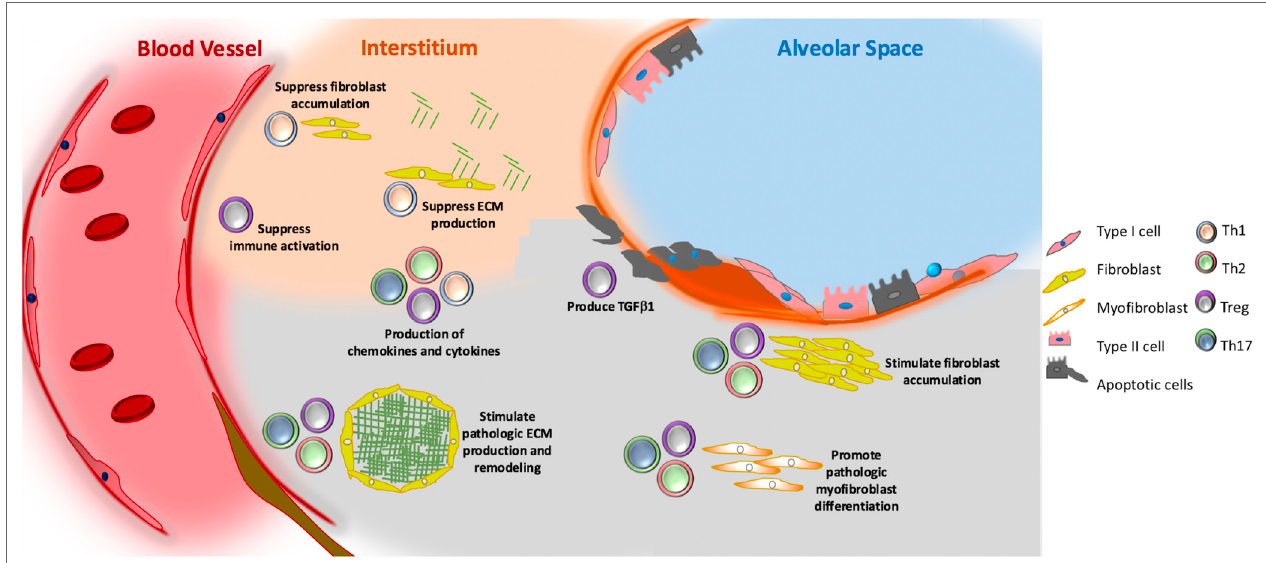
FigURe 3 | Putative role of adaptive immunity in idiopathic pulmonary fibrosis. Th1 (grey) cells may suppress fibroblast responses through the secretion of pro-inflammatory cytokines, such as interferon gamma and TNF α . Th2 (pink) and Th17 (green) cells stimulate fibroblast proliferation, activation, and extracellular matrix (ECM) production through their secretion of IL-4 and IL-13 (Th2) and IL-17 (Th17). Tregs (purple) may either promote fibrosis through production of PDGF β and TGF β 1, or suppress fibrosis via poorly understood effects on fibrocyte accumulation. Note that image is not drawn to